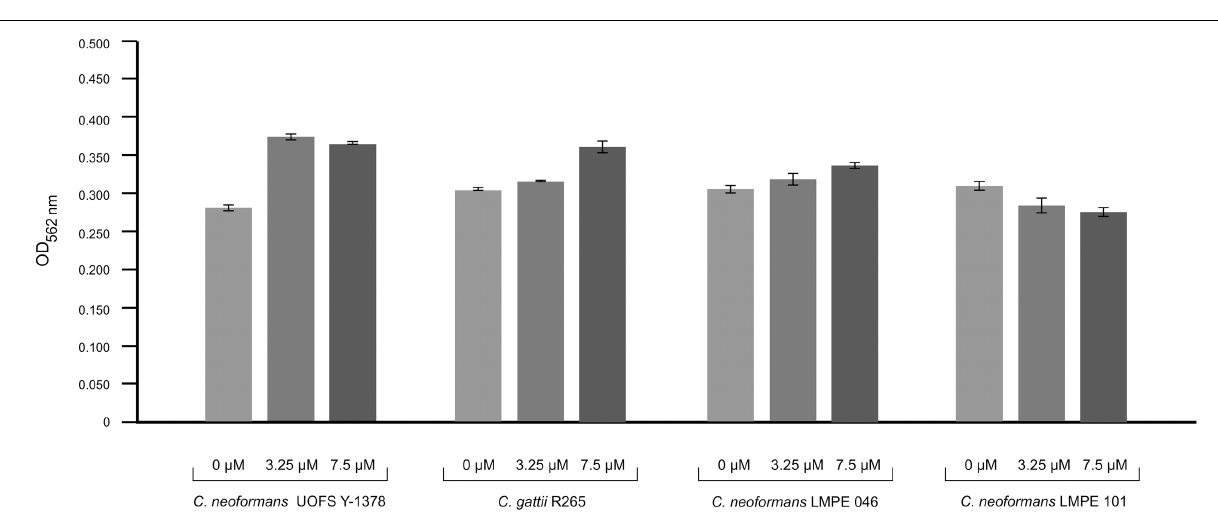
FIGURE 3 | The survival assay results showing the number of colony forming units (CFUs) that were enumerated after the acapsular strain C. neoformans LMPE 101 was exposed to different treatment conditions. The results suggest that 3-hydroxy C9:0, similar to GXM, protect cells against oxidative damage.